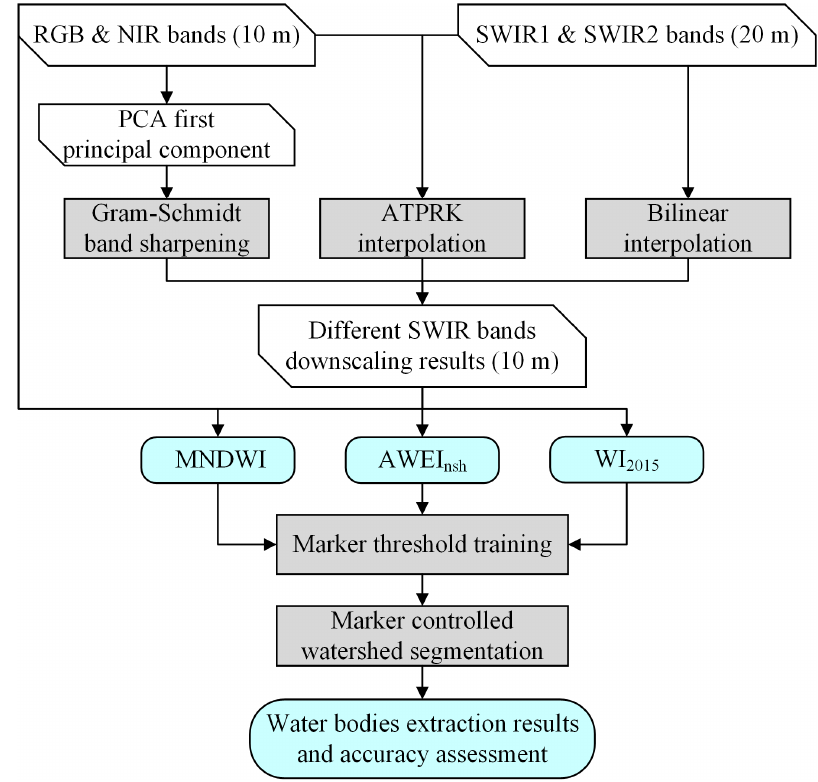
Figure 2. Workflow of the remote sensing water body extraction.